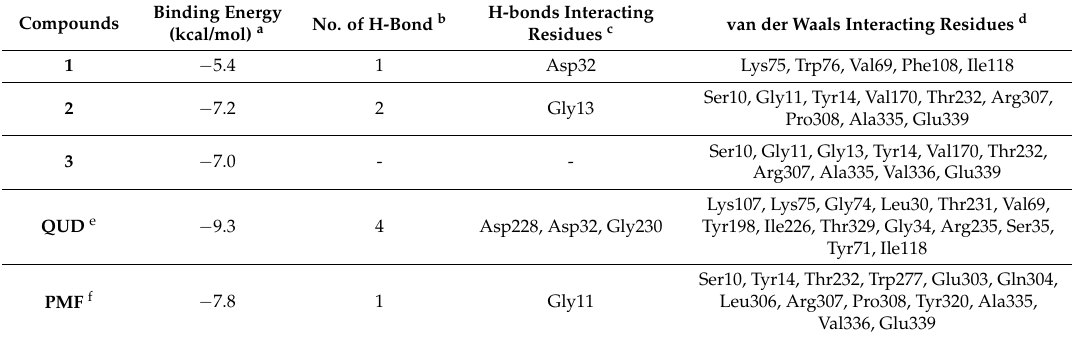
Table 3. Molecular interaction of the BACE1 active site with 1 – 3 and the inhibitors QUD and PMF.